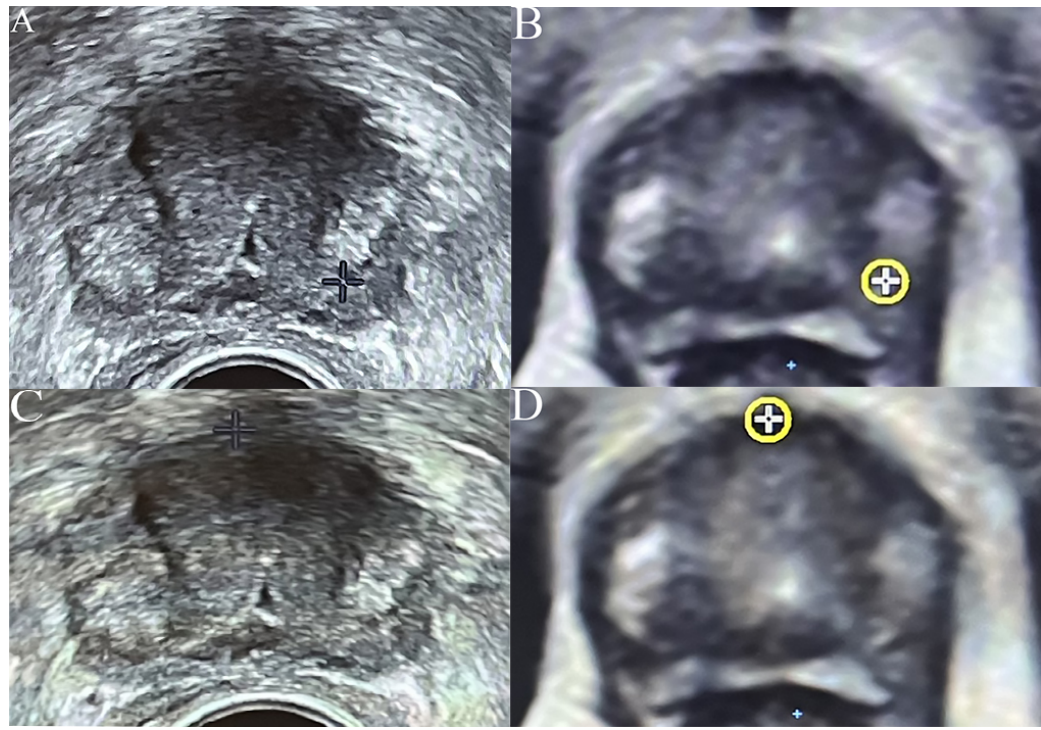
Fig. 1. On the left TRUS (A,C) and on the right mpMRI (B,D). The cross in the pictures shows the boundary among central/transition and peripheral zone and the boundary of the anterior zone of the prostate. Urethra, and rectal wall may be seen in both modalities further confirming the correct overlap of the